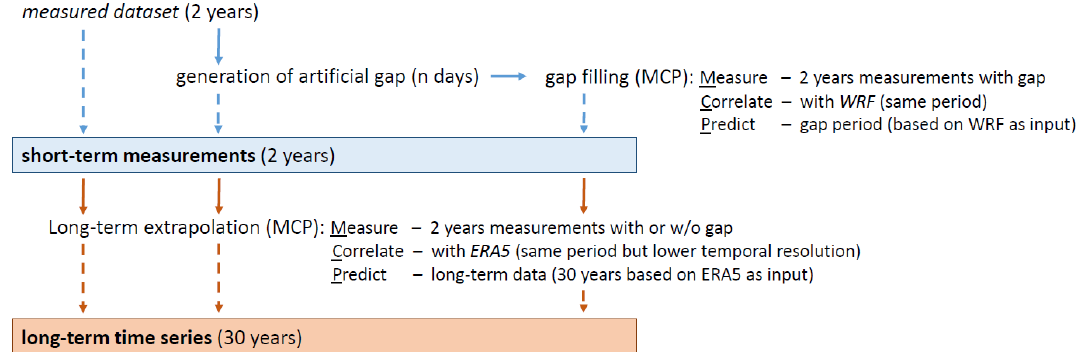
Figure 7. Workflow followed in our study including the MCP approaches for the gap-filling and long-term extrapolation procedures.